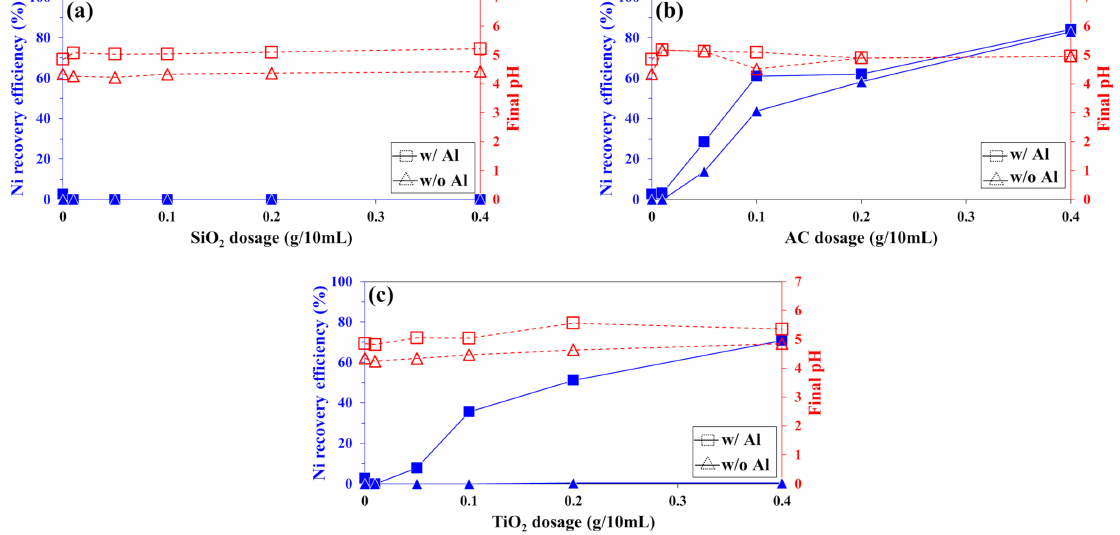
Figure 3. The effects of ( a ) SiO 2 , ( b ) AC, and ( c ) TiO 2 dosages on the recovery efficiency of Ni 2+ and final pH in sulfate solutions at initial pH 4.0 for 24